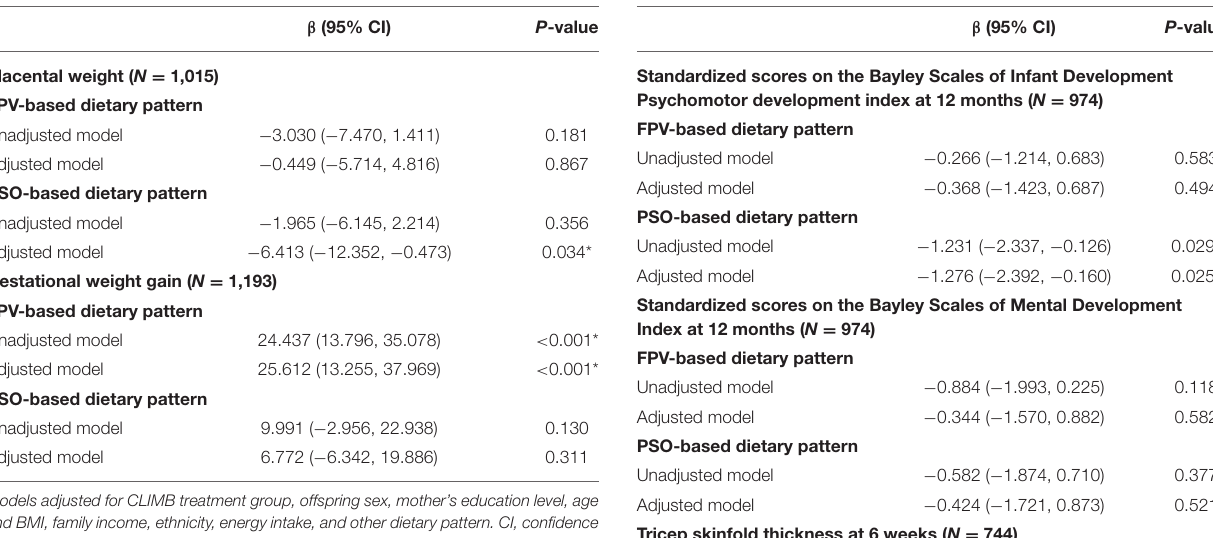
TABLE 4 | Linear regression analyses of dietary pattern scores and pregnancy outcomes.